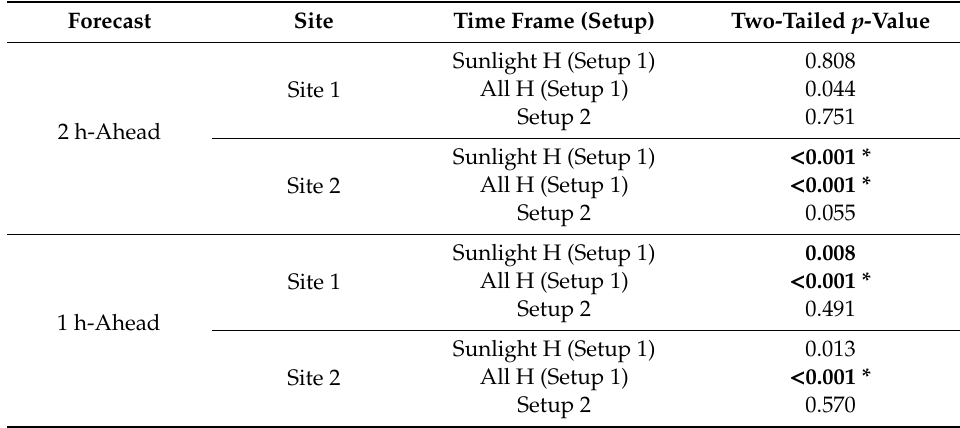
Table 13. Statistical significance of the t -test evaluation in terms of p -value at a significance level of 1%. Two-tailed p -values are used to evaluate the statistical significance of the results (bold text indicates p -values that are below 1% significance level, while the asterisk highlights very low p -values that are